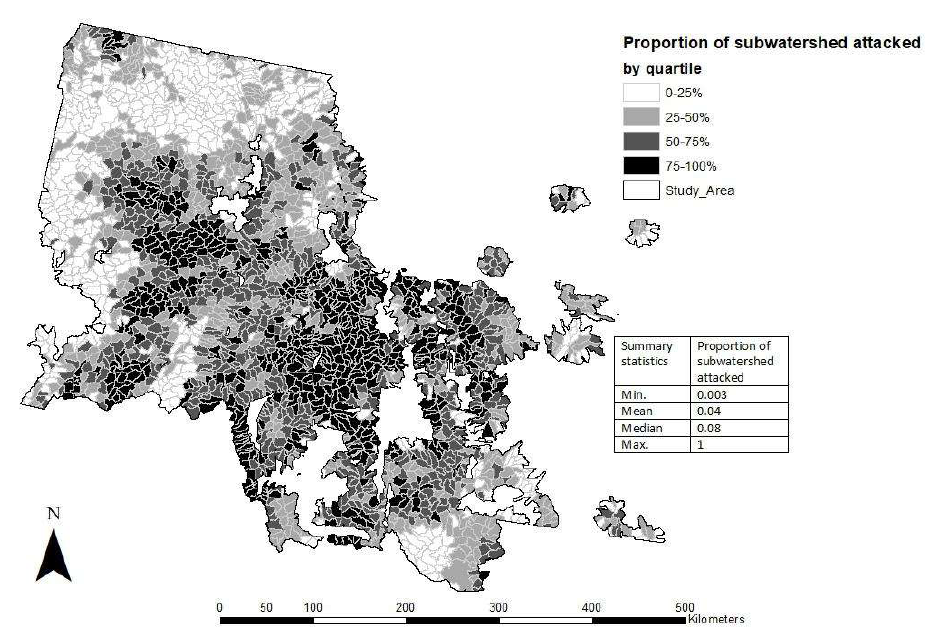
Figure 4. Subwatershed MPB attack severity by quartile, with summary statistics of proportion of area attacked in a subwatershed at high severity. Table 3. Summary statistics of subwatersheds at or above the 75th quartile for subwatershed MPB attack severity for HIGH and below the 75th quartile for LOW ( n = 2262). See Table 1 for variable descriptions.